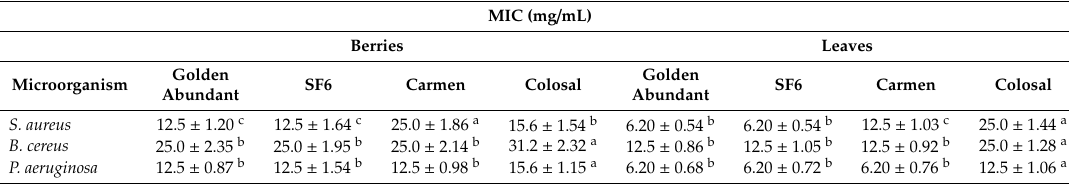
Table 6. Antimicrobial activity (MIC) of the extracts of Hippophae rhamnoides L. ssp. carpatica berries and leaves against four bacterial species. MIC (mg / mL) Berries Leaves Golden Golden SF6 Carmen Colosal SF6 Carmen Colosal Microorganism Abundant Abundant S.